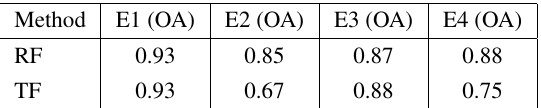
Table 6. SSL with 11 time steps: Overall accuracy (OA) with all data; OA with 0% labels for 2018; with 5% labels and 10% for